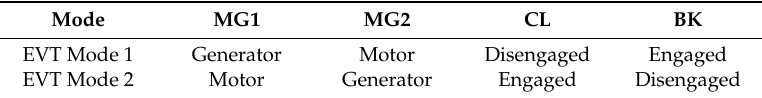
Table 1. Operation modes of the hybrid HDV with PST: CL: clutch; BK: